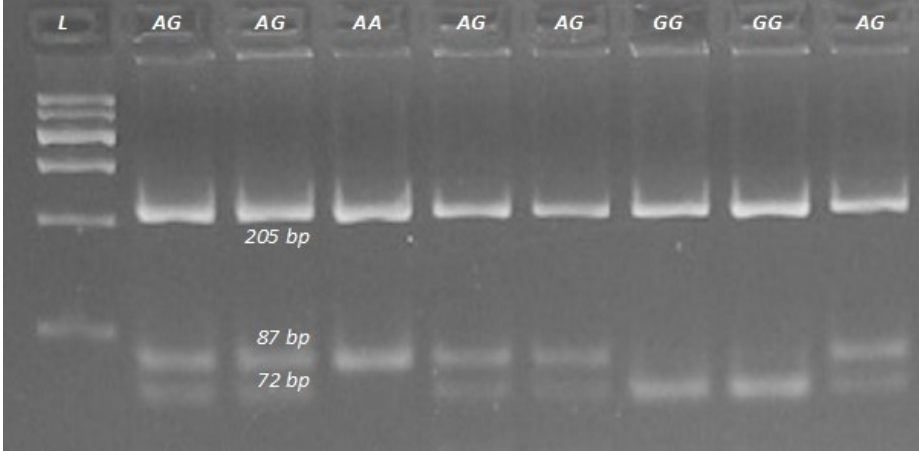
Figure 2. Genotyping the rs209202414 A-to-G polymorphism in the bovine FADS2 gene. Digestion with TseF I restriction enzyme revealed the AA , AG , and GG genotypes. L is a 600bp DNA ladder.